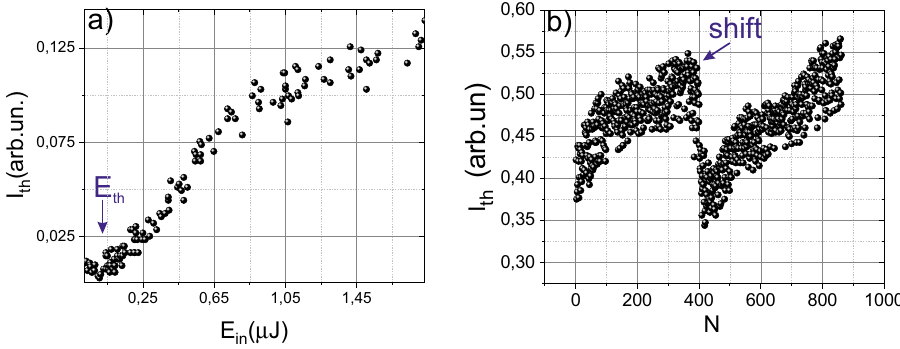
Figure 2. ( a ) Dependence of the third harmonic generation efficiency on the laser pulse energy. The arrow indicates the plasma formation threshold. The sample is moved from pulse to pulse. ( b ) Dependence of the third harmonic signal on the number of laser pulses. The arrow indicates the moment of the silicon sample